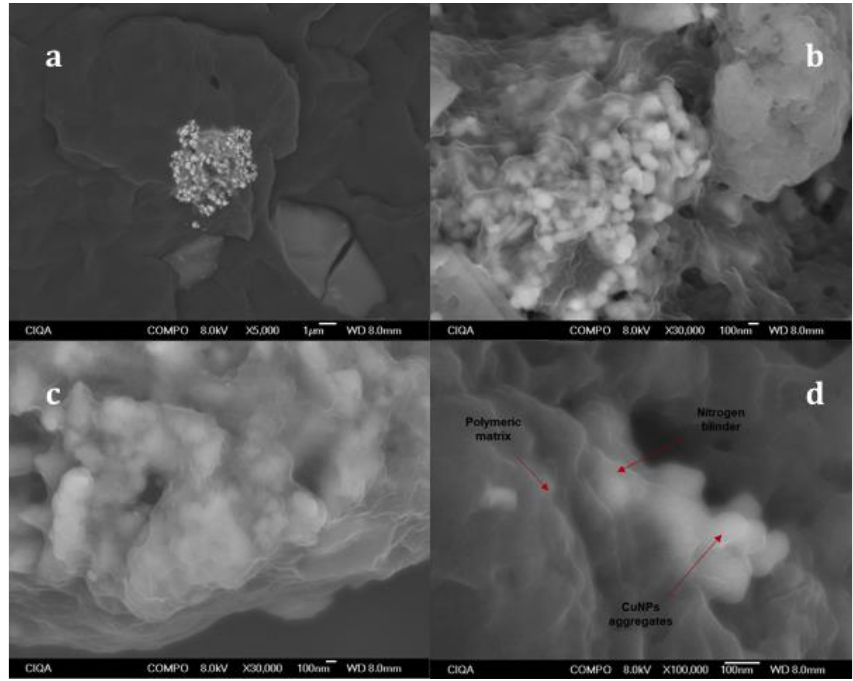
Figure 2. SEM images with different magnification ( a ) 5000, ( b ) 30,000, ( c ) 30,000, and ( d ) 100,000 times of sample iPP/CuNPs 0.25 wt %.